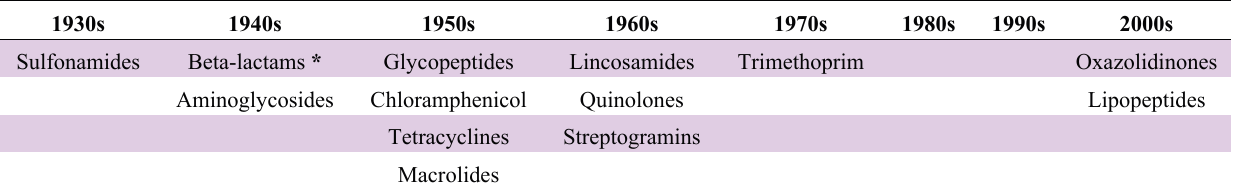
Table 2. Discovery of antimicrobial drugs during